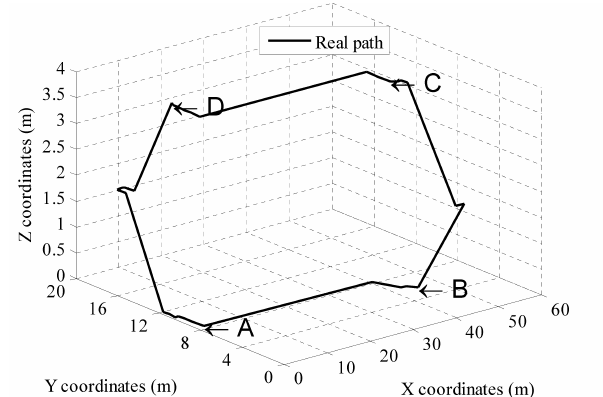
Figure 10. Real path of the target.